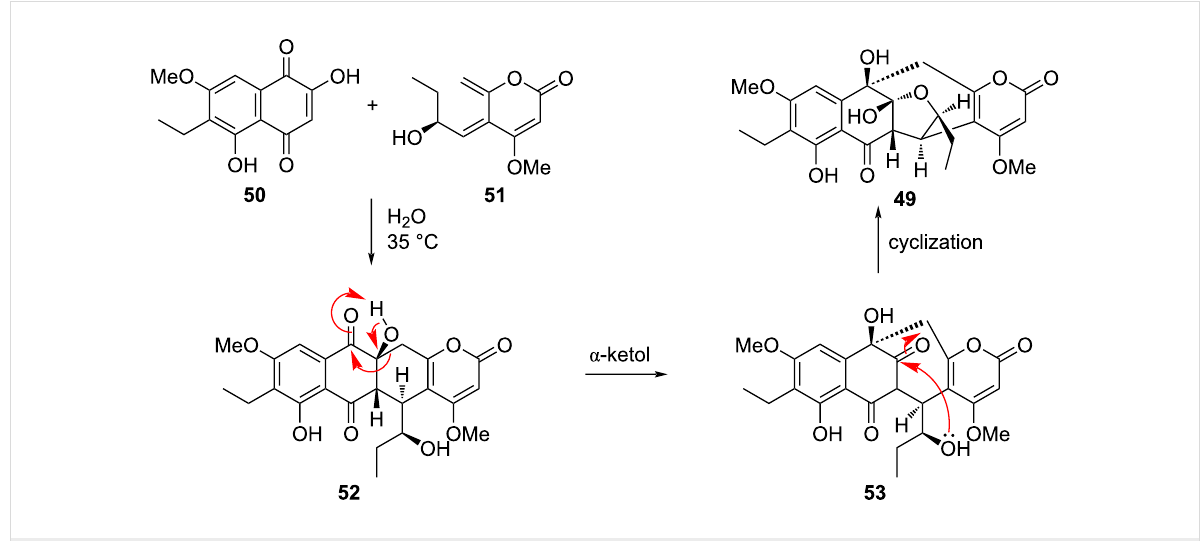
Figure 12: Tandem reaction consisting of a Diels–Alder cycloaddition followed by an α -ketol rearrangement, part of the total synthesis of delitschiapy- rone A ( 49 ).